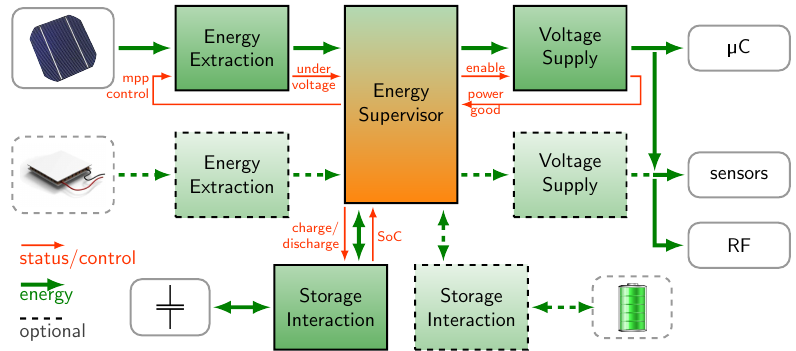
Figure 2. An illustration of a function-oriented structure of a power management. In a real system the functions energy extraction , storage interaction and voltage supply shown in green are realized with power